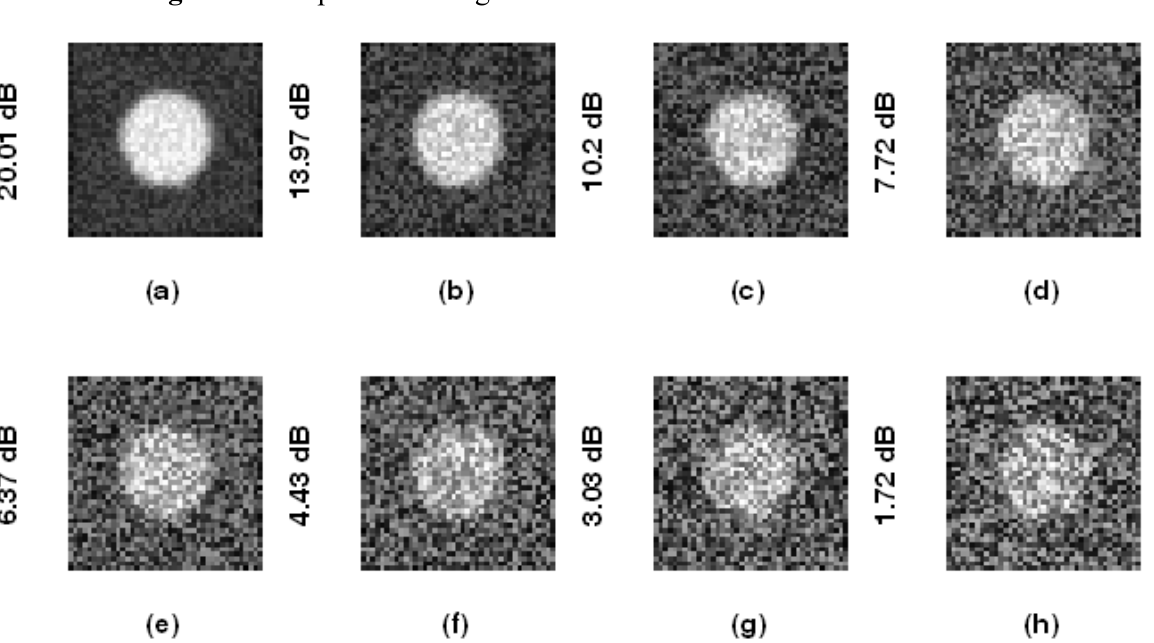
Figure 4. The phantom images with added noise from different